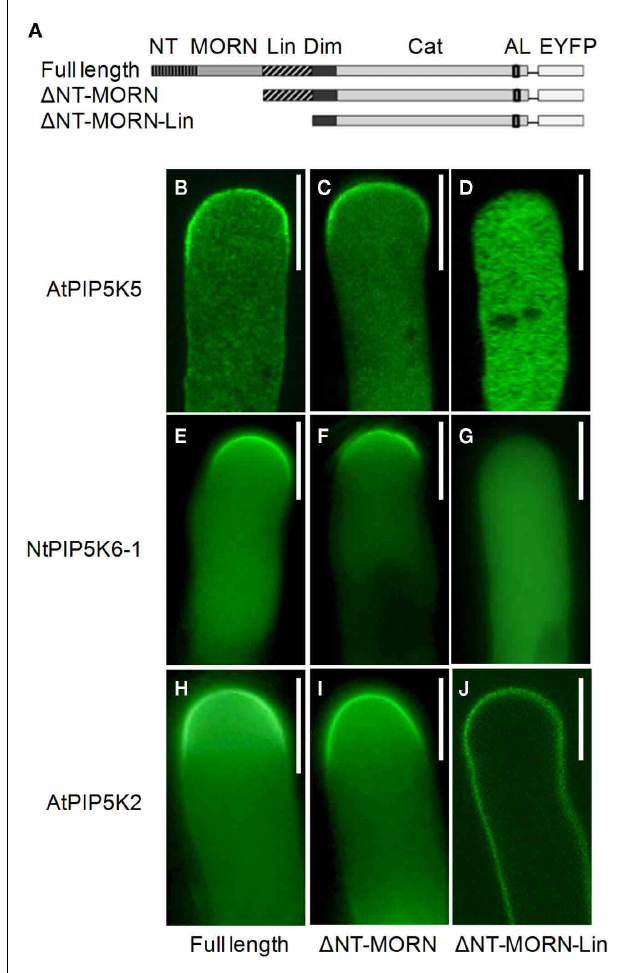
FIGURE 2 |The Lin domain is required for correct localization of AtPIP5K5, NtPIP5K6-1, andAtPIP5K2. The PI4P 5-kinases AtPIP5K5, NtPIP5K6-1, and AtPIP5K2 belong to subfamily B and share the same domain structure. N-terminal domains of AtPIP5K5, NtPIP5K6-1, and AtPIP5K2 were systematically deleted, the truncated variants fused to EYFP-tags, the fusion proteins expressed in tobacco pollen tubes, and the fluorescence distribution was monitored. (A) Graphical representation of the domain structure of full-length AtPIP5K5, NtPIP5K6-1, or AtPIP5K2. NT, N-terminal domain; MORN, MORN domain; Lin, linker domain; Dim, dimerization domain; Cat, catalytic domain; AL, activation loop; EYFP, fluorescence-tag. Δ NT–MORN, graphical representation of the Δ NT–MORN truncations; Δ NT–MORN–Lin, graphical representation of the